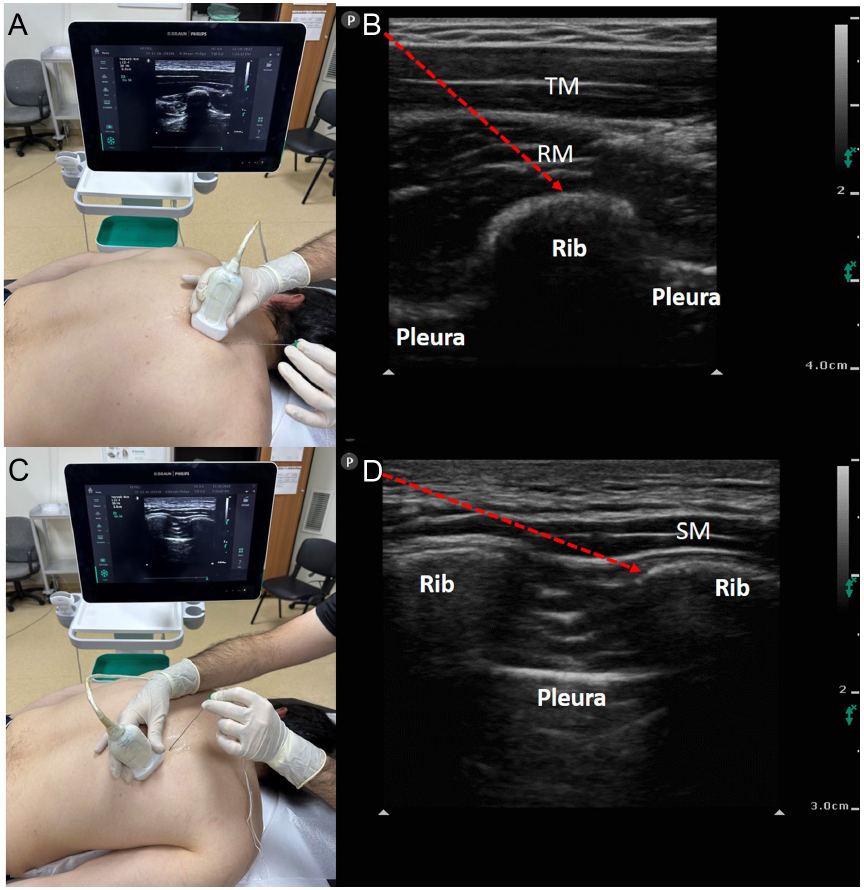
Figure 3. A-D. (A–C) Patient and ultrasound probe position for rhomboid intercostal sub-serratus block procedure. (B–D) Sonographic anatomy of the block. RM, rhomboid muscle; SM, serratus muscle; TM, trapezius muscle; red arrow,